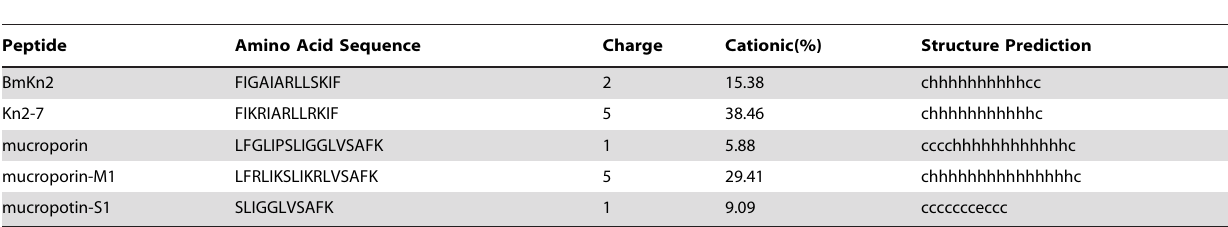
Table 1. The charge, first and predict secondary structure of scorpion venom peptides.